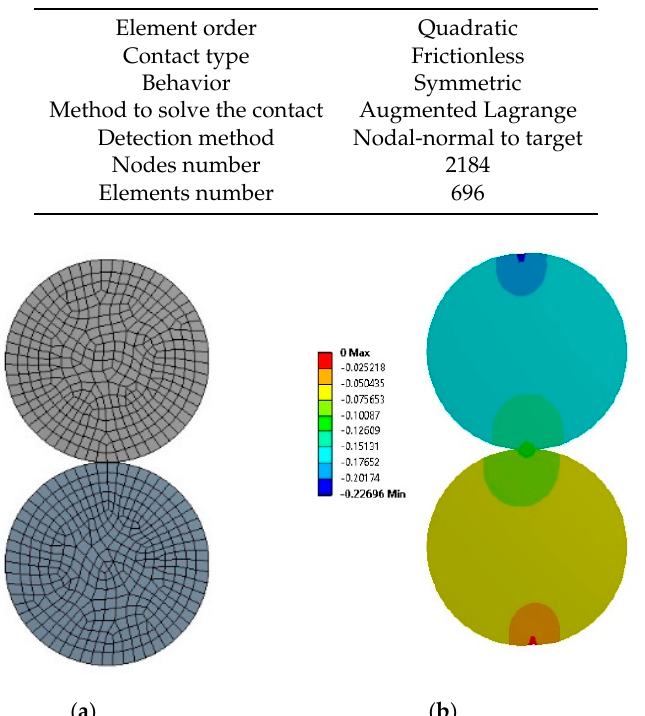
Table 5. Parameters to solve the contact problem with FEM.